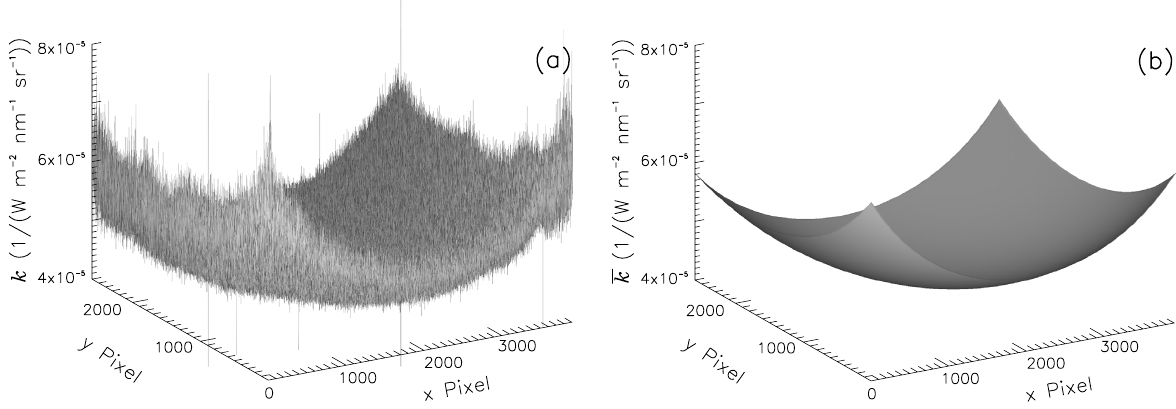
Fig. 3. Radiometric calibration coefficients k and ¯ k of camera channel 1 ( λ = 591nm). Panel (a) shows the noisy raw data ( k ). In Panel (b) a two-dimensional fit was applied to smooth the data ( ¯ k ). The calibration is valid for an exposure time of 1/2656s, an f-number of F/9.1, and a film speed of